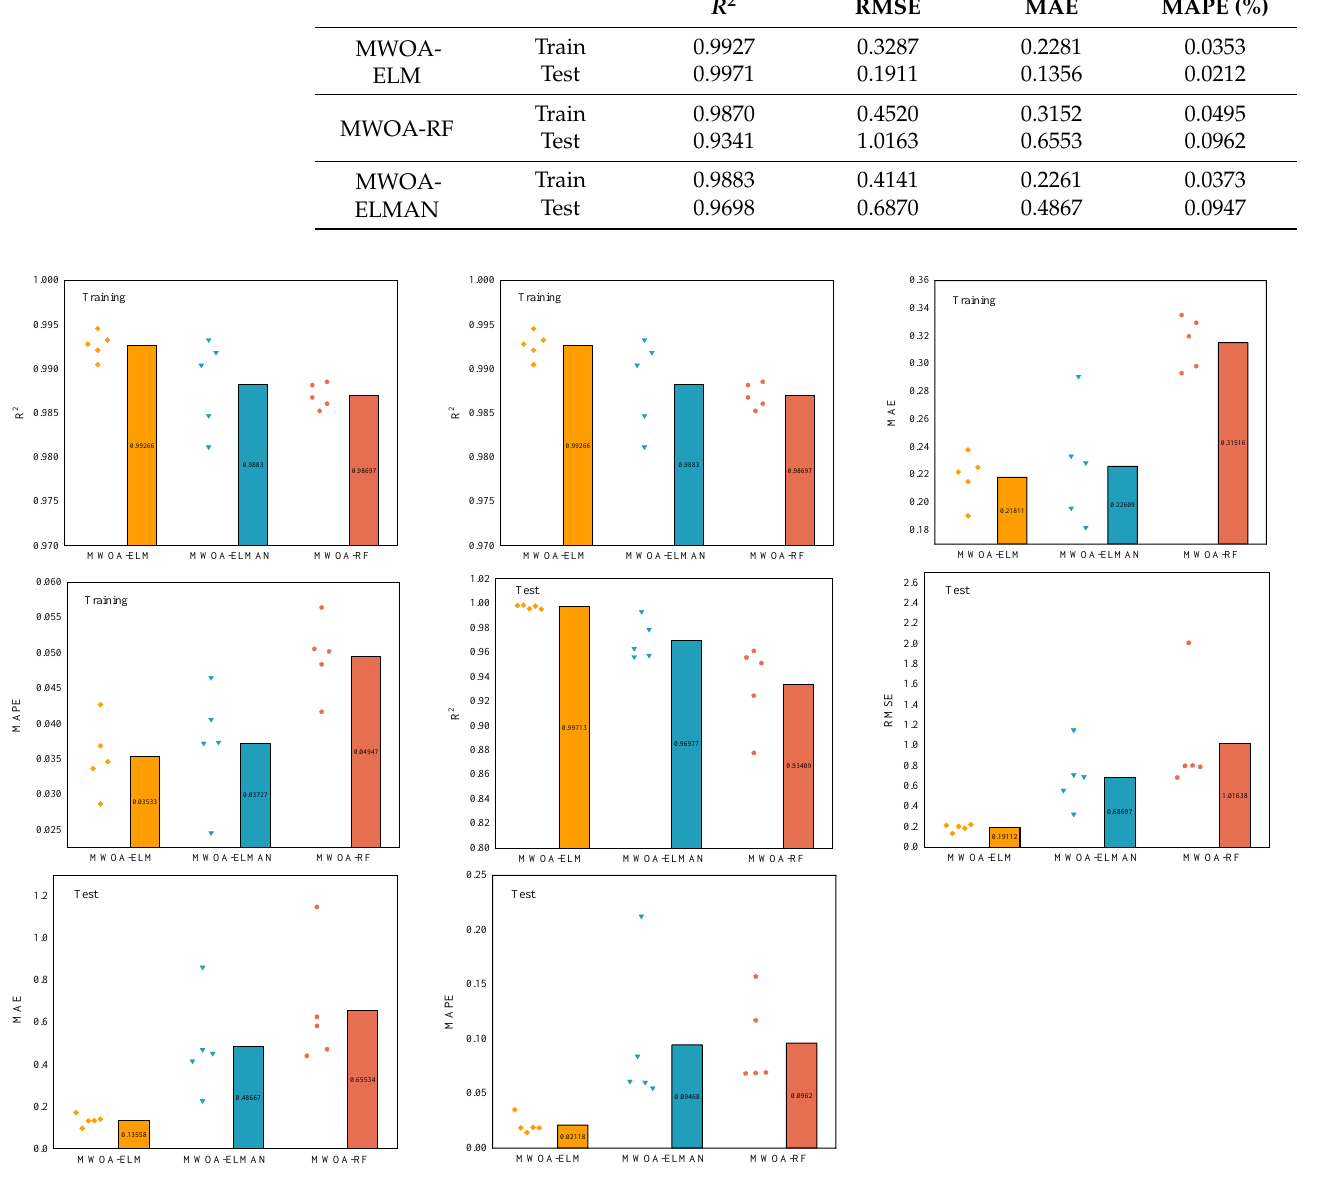
Figure 13. Box line plots of the Training and Testing sets for MWOA-ELM, MWOA-RF and MWOA- ELMAN models.